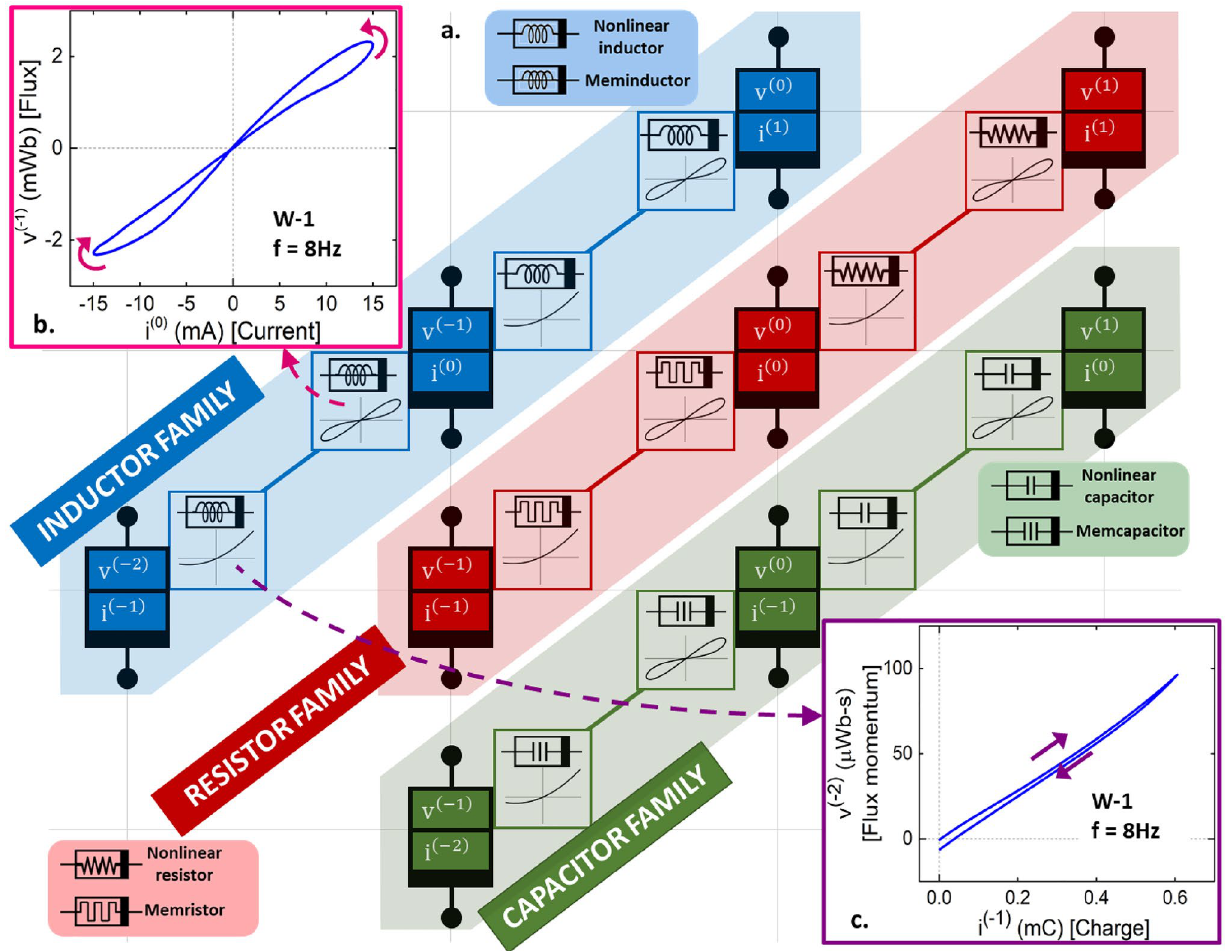
Figure 4. Position of the fabricated device on the periodic table of elements. ( a ) Leon Chua’s periodic table of two-terminal circuit elements with diagonals corresponding to the resistor, capacitor, and inductor families highlighted. The insets next to each (α, β) cell indicate the circuit elements with constitutive relationship and pinched hysteresis behavior in the (v (α) − i (β) ) plane. Electrical symbols of the six known nonlinear circuit elements are shown alongside their respective diagonals. ( b , c ) The device fabricated in this work exhibits a pinched hysteresis response in the (v (−1) − i (0) ) plane thus confirming its meminductive properties ( b ), and a multi-valued response in the (v (−2) − i (−1) ) plane reveals that the device is a generic meminductor ( c